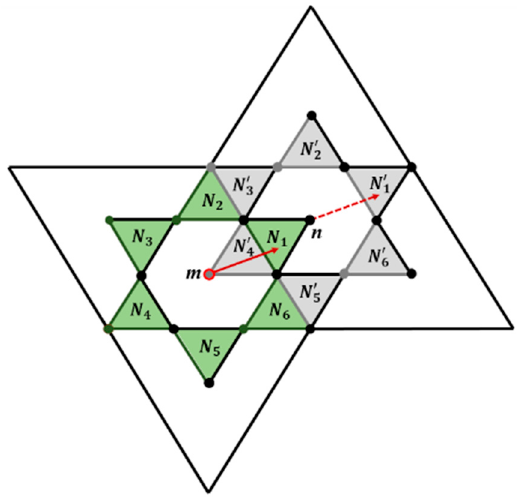
Figure 11. A translation to a non-bijective region N i . Image of an even and of an odd pixel (with the corresponding regions N (cid:48) . where i = 1 ... 6) is i